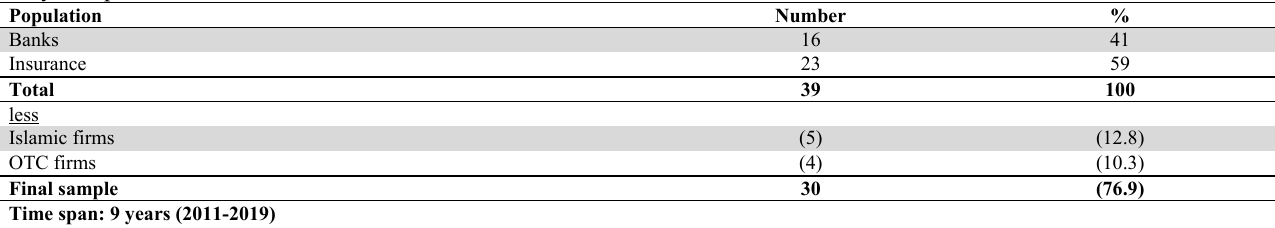
Study Sample Selection